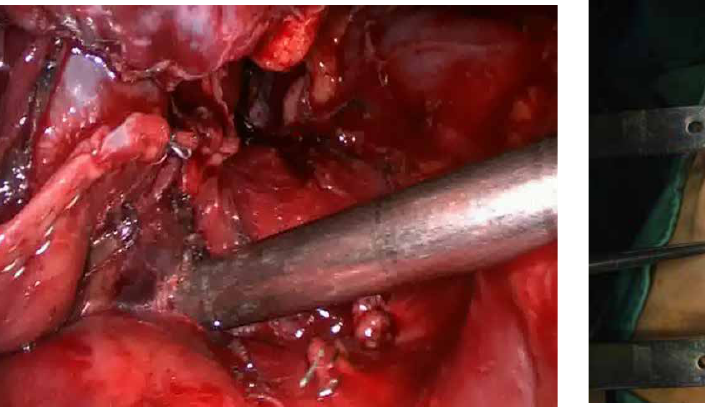
Figure 1: VATS lobectomy plus mediastinal linfadenectomy. Figure 2: Lower left lobectomy in